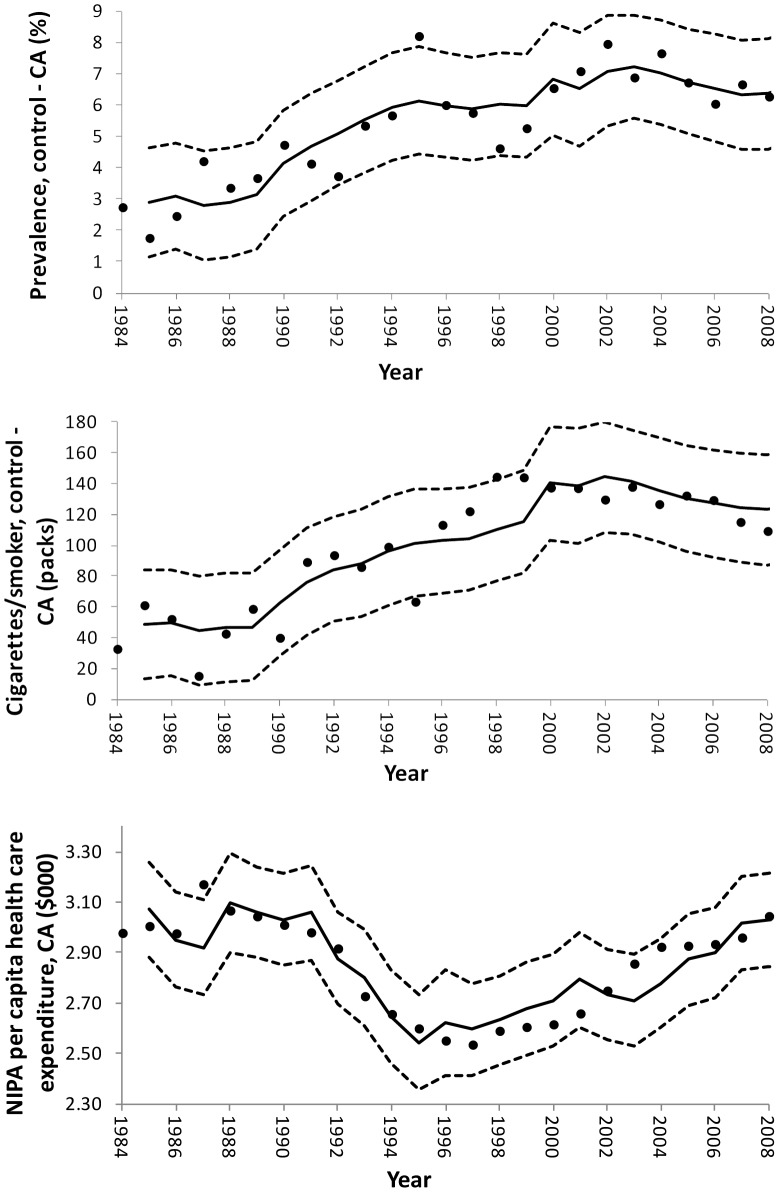
Observed and predicted smoking prevalence, cigarette consumption per smoker and per capita healthcare expenditures.Top panel: Difference between California and control state current smoking prevalence (Equation 1), middle panel: difference between California and control state cigarette consumption per smoker (Equation 2), bottom panel: California per capita healthcare expenditures using the NIPA measure (Equation 3). Black circles: observed, solid line: in-sample predictions from regression estimates, dashed lines: 95 percent forecast confidence intervals for prediction of individual observations.